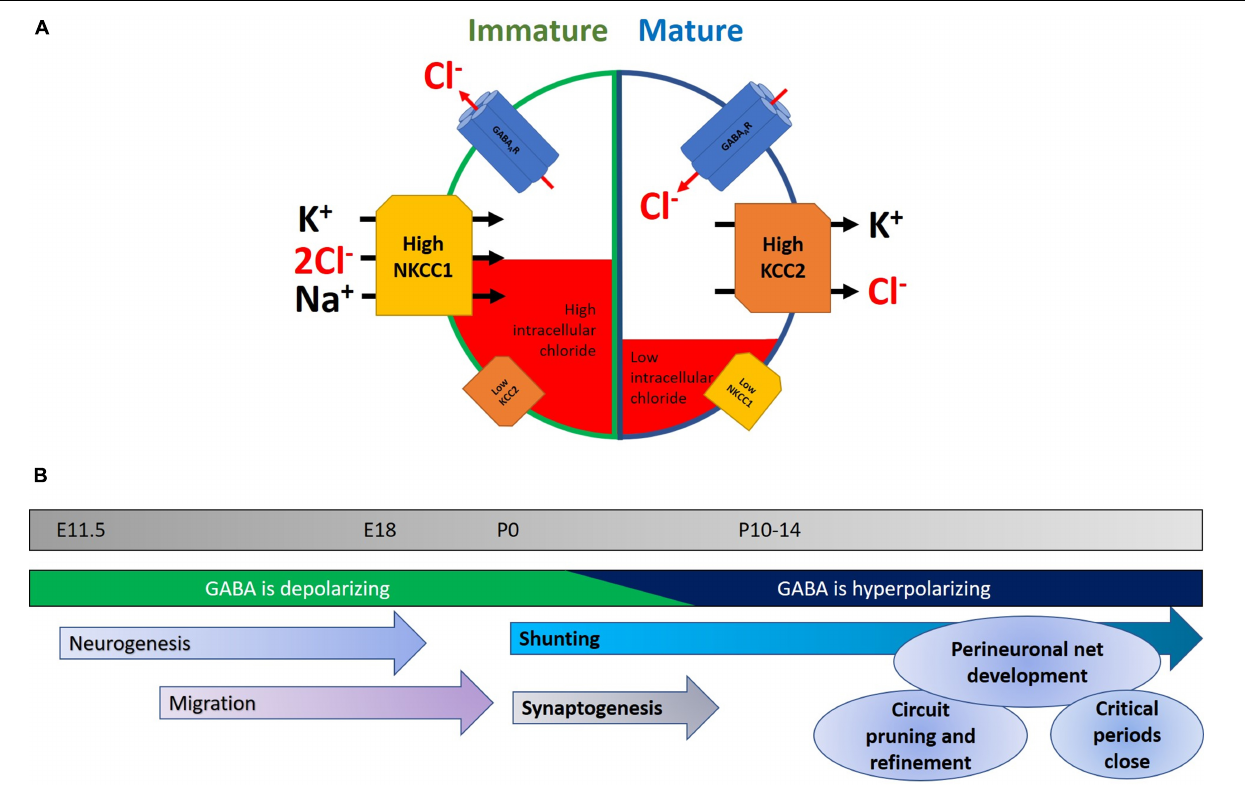
FIGURE 1 | (A) Developmental changes in NKCC1 and KCC2 within neurons. In immature neurons, NKCC1 is expressed at high levels and is stabilized at neuronal plasma membranes, where it transports chloride into the cell, along with potassium and sodium. A concomitant low level of KCC2 expression keeps intracellular chloride levels high. The net result of this is that opening of GABA A receptors results in an efflux of chloride, leading to neuronal depolarization and a higher probability of neuronal activity. Later in development, the GABA-shift in neurons is primarily characterized by an upregulation of KCC2, potentially accompanied by a downregulation of NKCC1. This mature state is characterized by lower levels of intracellular chloride, and consequently chloride enters the cell upon GABAergic activity, and hyperpolarizes the neuron, reducing the likelihood of action potential generation. (B) Timeline highlighting some key events during early development. Normal development of the nervous system is characterized by a series of stages in which neurons are born, migrate to their final location, and then begin to make synapses. Early in the program, depolarizing GABA helps in aspects of neurogenesis, migration, and elevating activity in the nascent network. As the GABA-shift switches GABA to being hyperpolarizing, this coincides with the onset of an increase in glutamatergic synaptic drive. Later in development, interneuronal activity and structure continue to be refined with the formation of perineuronal nets and the closure of critical